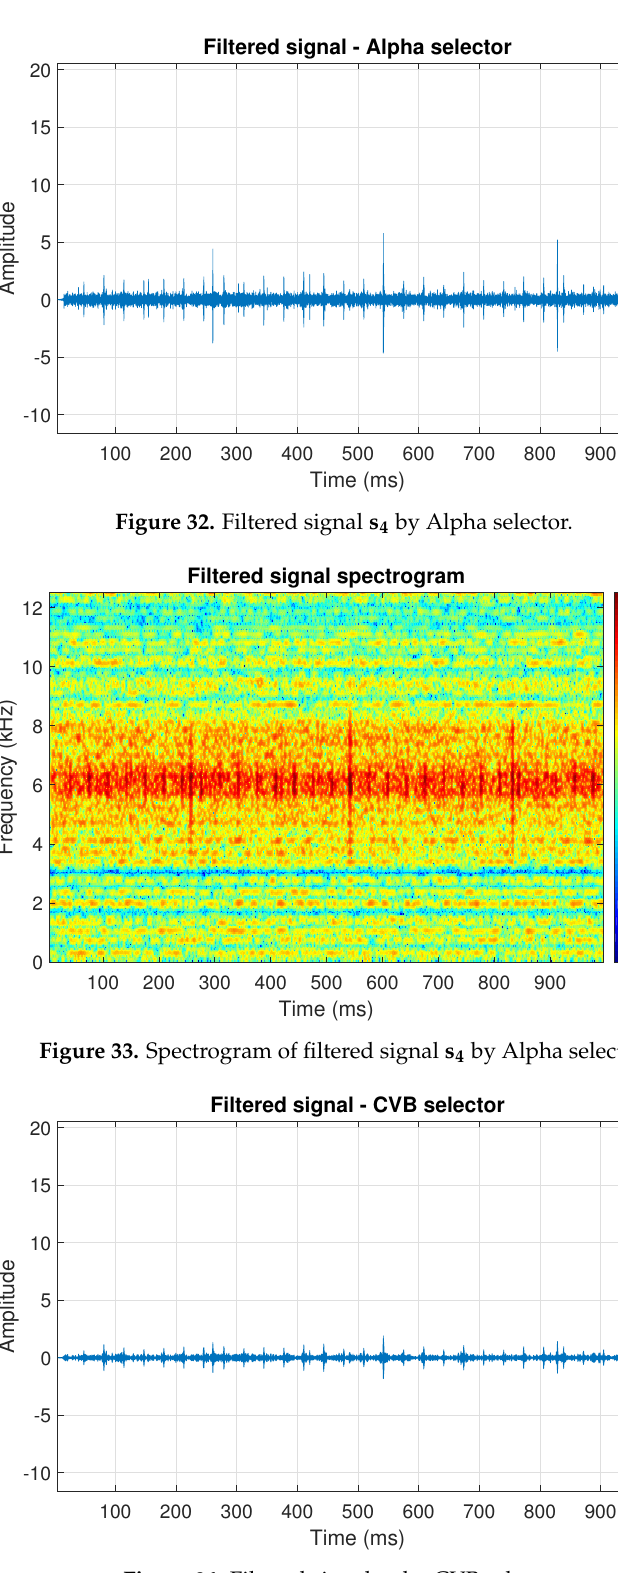
Figure 34. Filtered signal s 4 by CVB